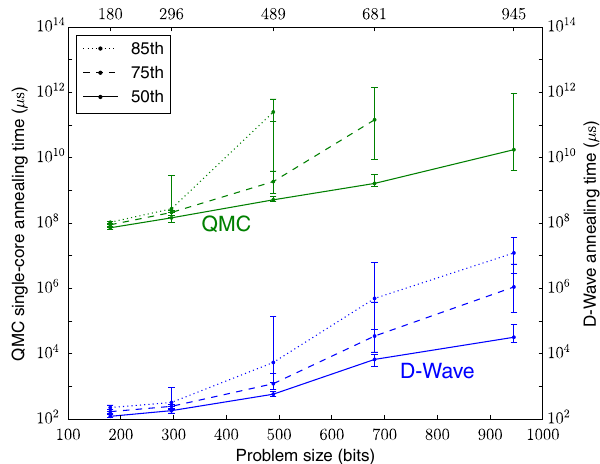
FIG. 12. Time to find the optimal solution with 99% probability for different problem sizes. We compare the QMC method with a linear schedule and the D-Wave 2X. To assign a runtime for the QMC code, we take the number of worldline updates that are required to reach a 99% success probability and multiply that with the time to perform one update on a single state-of-the-art core. Shown are the 50th, 75th, and 85th percentiles over a set of 100 instances. The error bars represent 95% confidence intervals from bootstrapping. The runtimes for the higher quantiles for the larger problem sizes for the QMC method were not computed because the computational cost was too